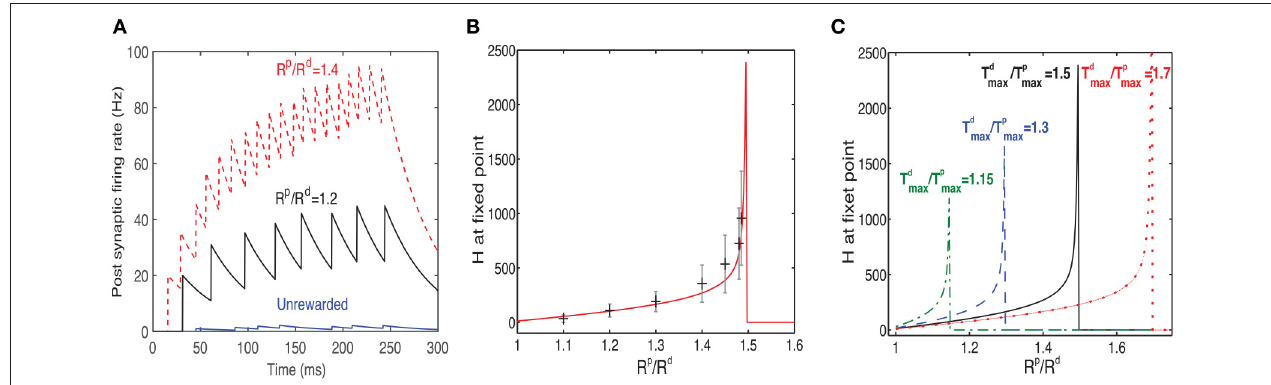
FIGURE 6 | Response to rewarded pattern can also learn to represent the magnitude of reward. (A) Two examples for the postsynaptic neurons firing rate, in response to the rewarded pattern after training and one for the unrewarded case. In one example (black) R p / R d = 1.2 and in the other (red) R p / R d = 1.4. The unrewarded pattern (blue) has a much lower firing rate. This result illustrates that a network trained with two different ratios of LTP vs. LTD associated reward ( R p / R d ) learns to represent the specific ratios. When R p / R d increases, so does the magnitude of the response to the rewarded pattern. Here T d max / T p max = 1.5. (B) The value of H at steady state increases monotonically as a function of R d / R p until a critical value is reached. Beyond this critical value the stable state is H = 0. The solid red line represents the analytical solution and the gray symbols represent the mean and standard deviation of simulations. The variability is over different synapses and time steps. All synapses associated with the rewarded pattern are taken into account. (C) H vs. R p / R d (as in B) but for different values of T d max / T p max .